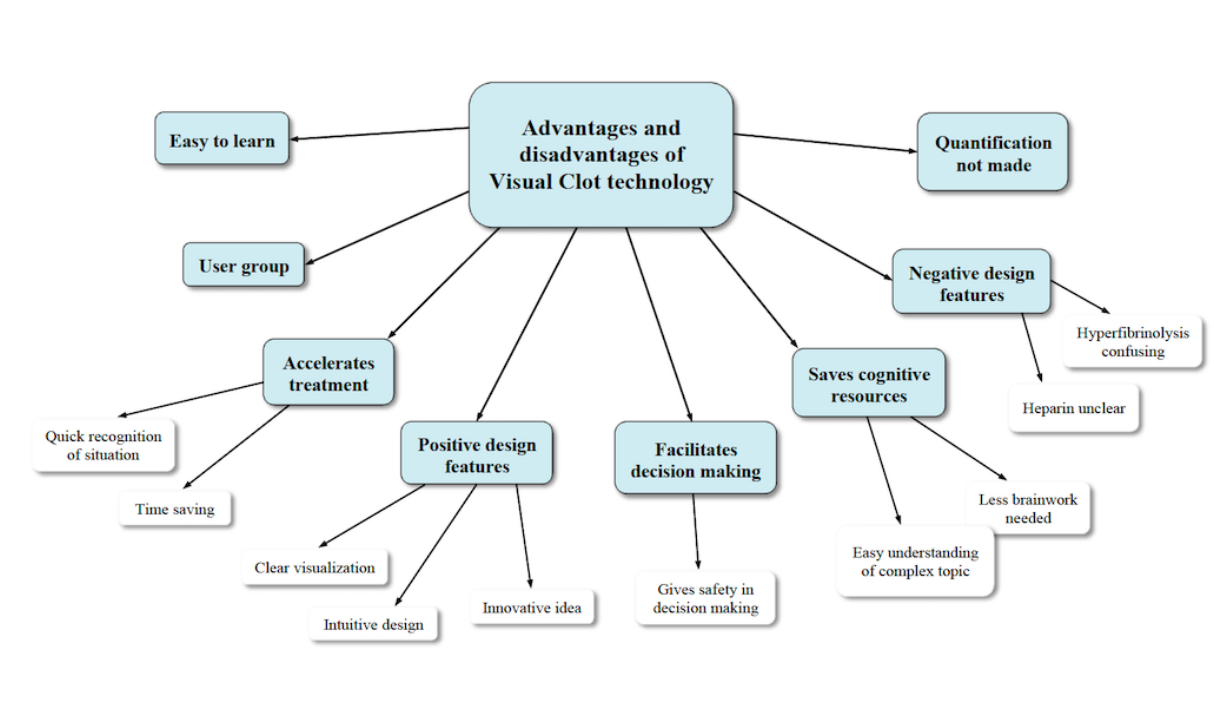
Figure 3. The coding template displaying the major topics and associated subthemes. We generated this through deductive coding via word count and inductive free coding of recurring topics in the interview field notes. A total of 36 participants were